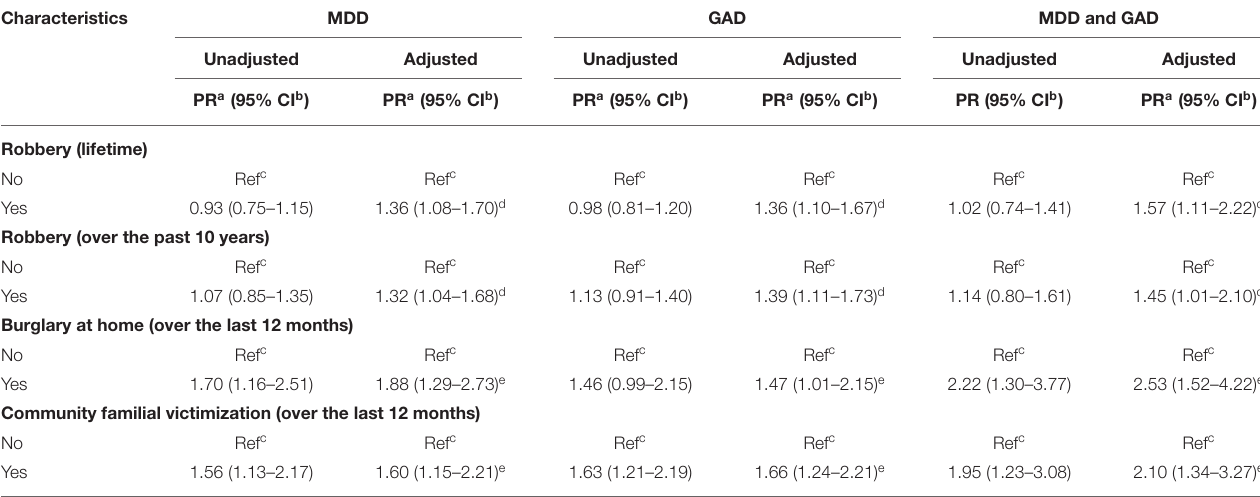
TABLE 4 | Relationship between robbery with Major Depressive Disorder (MDD), Generalized Anxiety Disorder (GAD) and MDD and GAD comorbidity, 1,982 Pelotas birth cohort, Brazil. Characteristics MDD GAD MDD and GAD Unadjusted Adjusted Unadjusted Adjusted